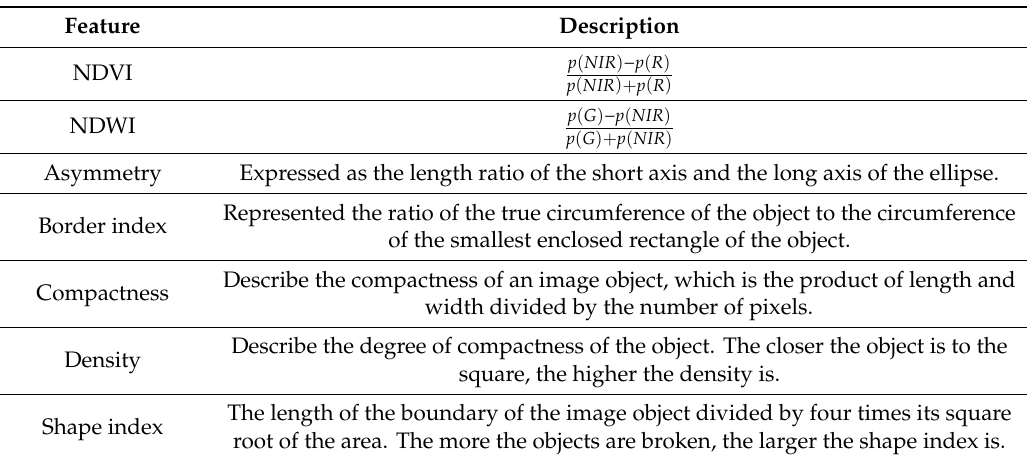
Table 4. Partial feature description.